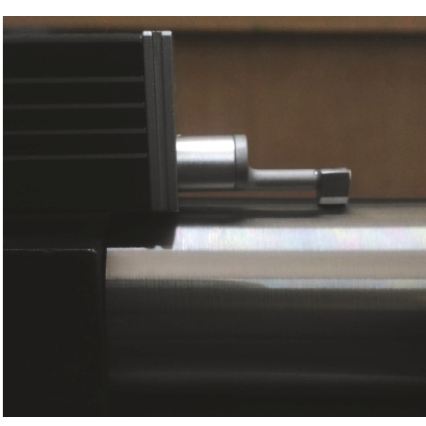
Figure 3: Measuring surface roughnesses with stylus on